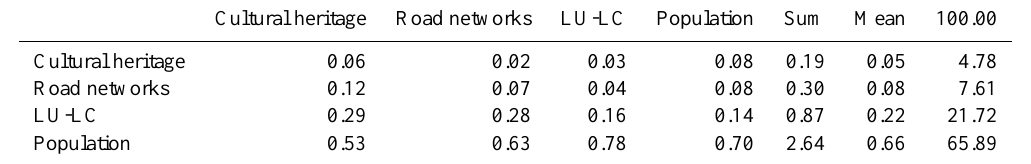
Table 8. Normalized matrix of socio-economic variables.